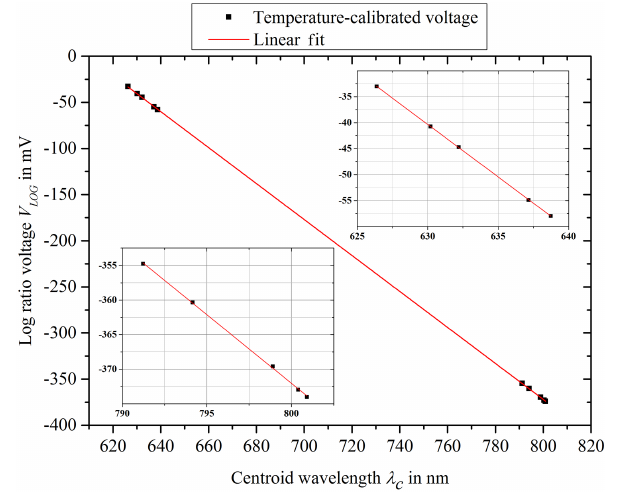
Figure 3. Measured log ratio voltage–centroid wavelength response of the readout